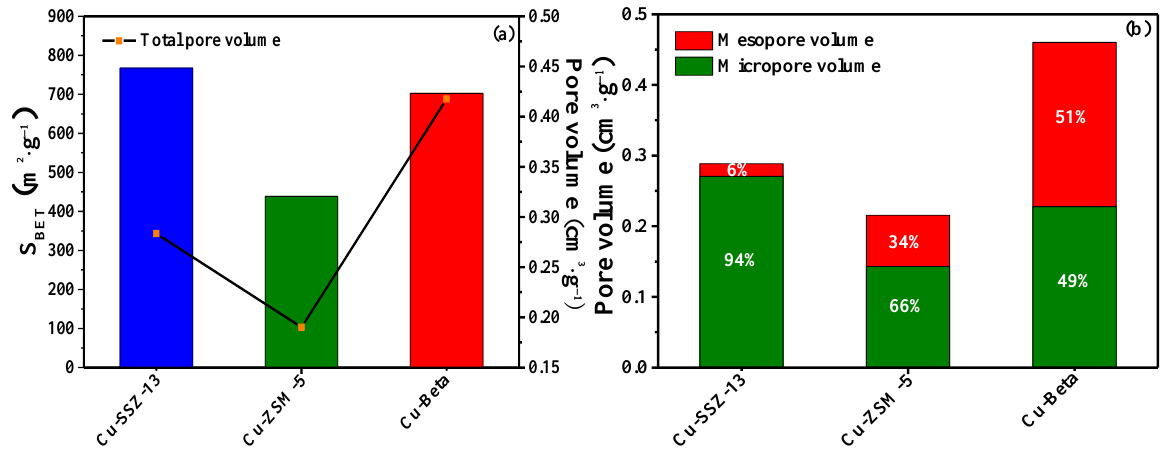
Figure 3. Specific surface area and pore structure parameters ( a ) and proportion of micropores and mesopores ( b ) of the copper-based zeolites.